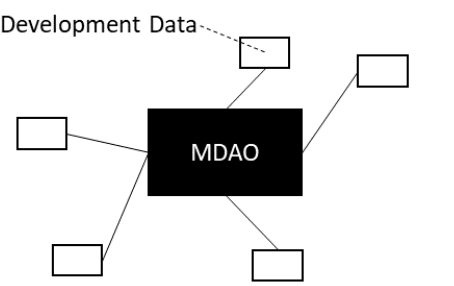
Figure 1. ( Left ): MDAO in document-centered development. Scattered data and black box behavior. ( Right ): MDAO in model-based development. Single source of data and resolved black box behavior.